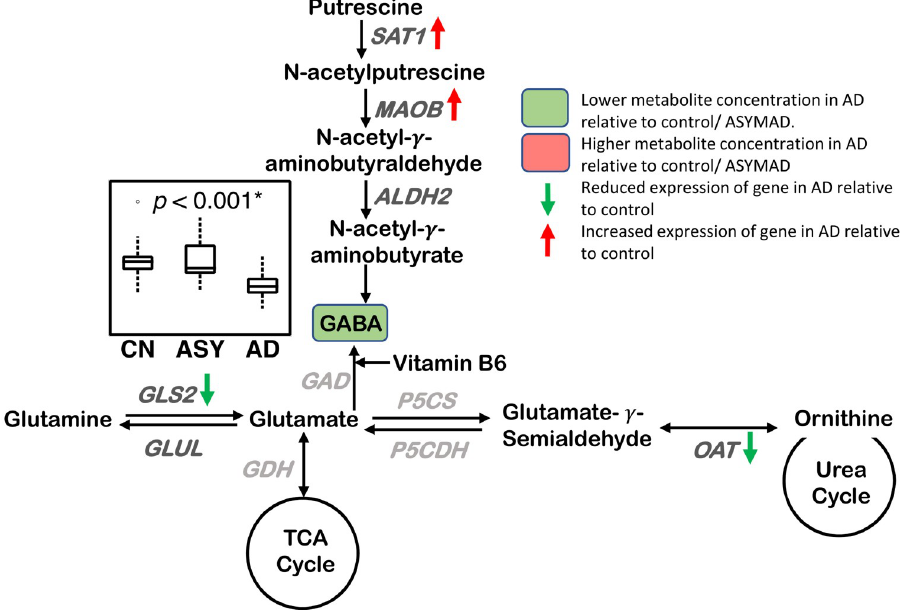
Fig 9. Neurotransmitter metabolism. A lower concentration of GABA is observed in AD in the ITG. The GABA synthesis genes, SAT1 and MAOB, have increased expression, and the genes GLS2 and OAT have reduced expression in the hippocampus/ERC in AD compared to CN. Sample size: AD = 17, ASY = 13, CN = 13; p -values indicate significance after FDR correction for multiple comparisons. An asterisk ( � ) indicates metabolite was also significant after Bonferroni correction. Genes in light gray indicate expression data were not available. AD, Alzheimer disease; ALDH2, aldehyde dehydrogenase 2; ASY, asymptomatic AD; CN, Control; ERC, entorhinal cortex; FDR, false discovery rate; GAD, glutamate decarboxylase; GDH, glutamate dehydrogenase; GLS2, glutaminase 2; GLUL, glutamate-ammonia ligase; ITG, inferior temporal gyrus; MAOB, monoamine oxidase B; OAT, ornithine aminotransferase; P5CDH, delta-1-pyrroline-5-carboxylate dehydrogenase; P5CS, delta-1-pyrroline-5-carboxylate synthase; SAT1, spermidine/spermine N1-acetyltransferase 1/diamine N-acetyltransferase; TCA, tricarboxylic acid